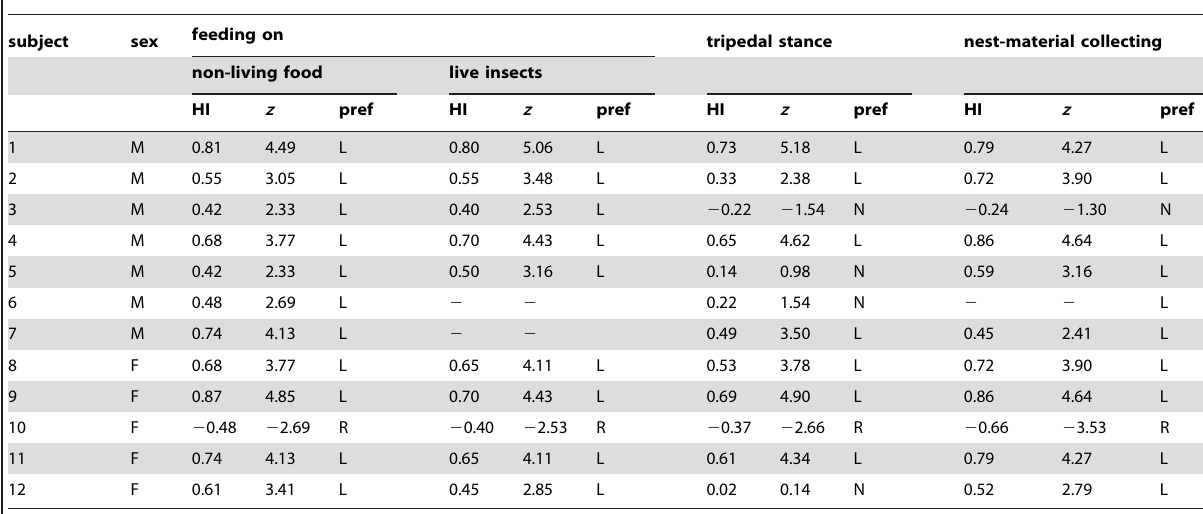
Table 1. Individual forelimb preferences in brush-tailed bettongs.